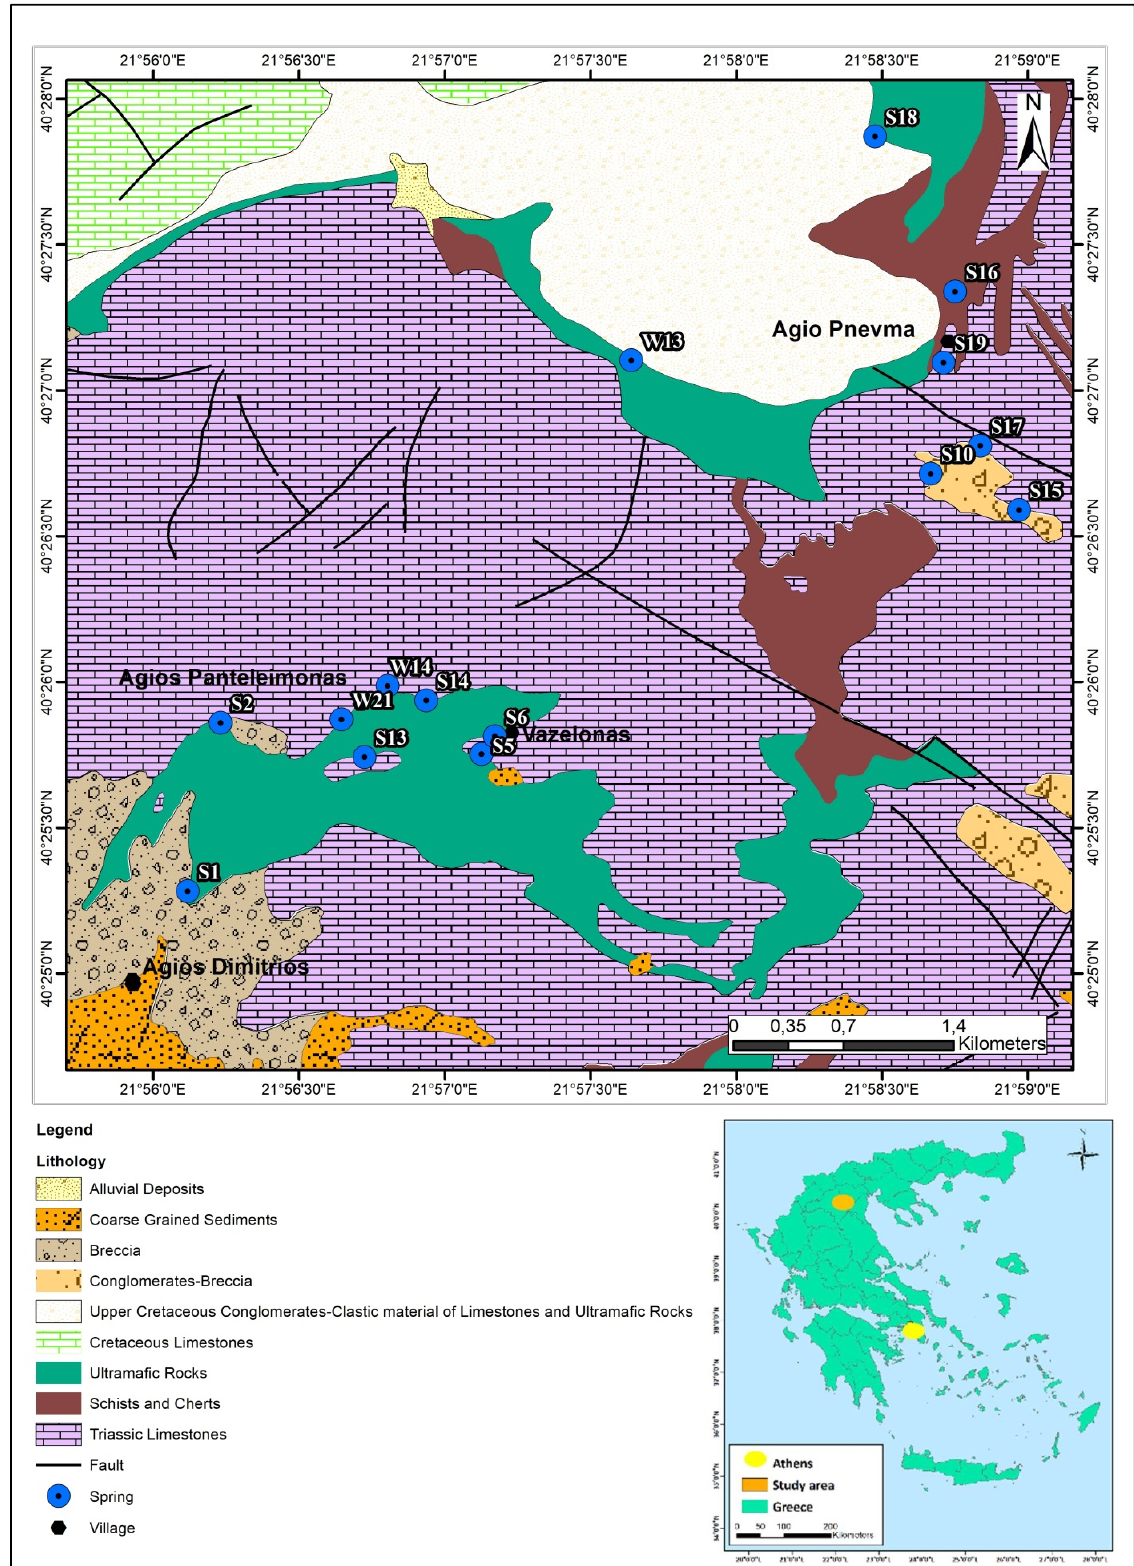
Figure 1. A simplified geological map of the western Vermio Mt.; the natural springs studied 131 herein are marked. 132